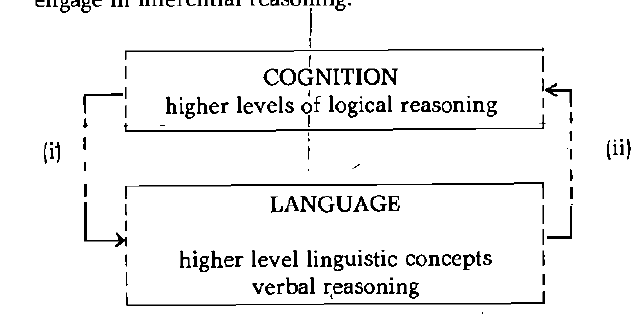
Figure 3: Interactional model of verbal-cognitive